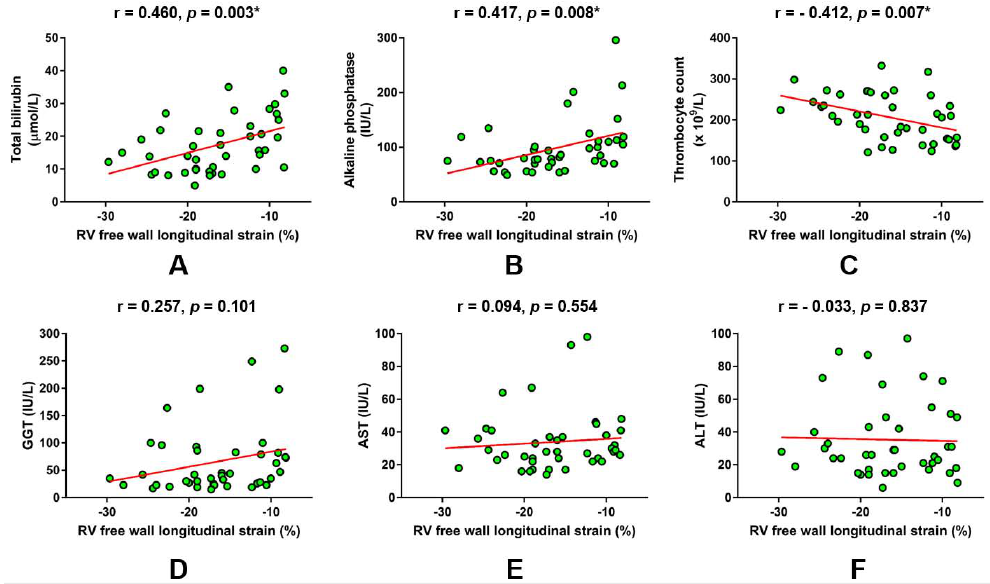
Figure 1. Linear regression plots showing the correlation of right ventricular (RV) free wall longitudinal strain with respect to laboratory parameters reflecting hepatic function and cholestasis. ( A ) Total bilirubin, ( B ) alkaline phosphatase, ( C ) Thrombocyte count, ( D ) gamma-glutamyl transferase, ( E ) aspartate aminotransferase, ( F ) alanine aminotransferase. * Significant statistical association at two-tailed level. r-Pearson’s correlation coe ffi cient.